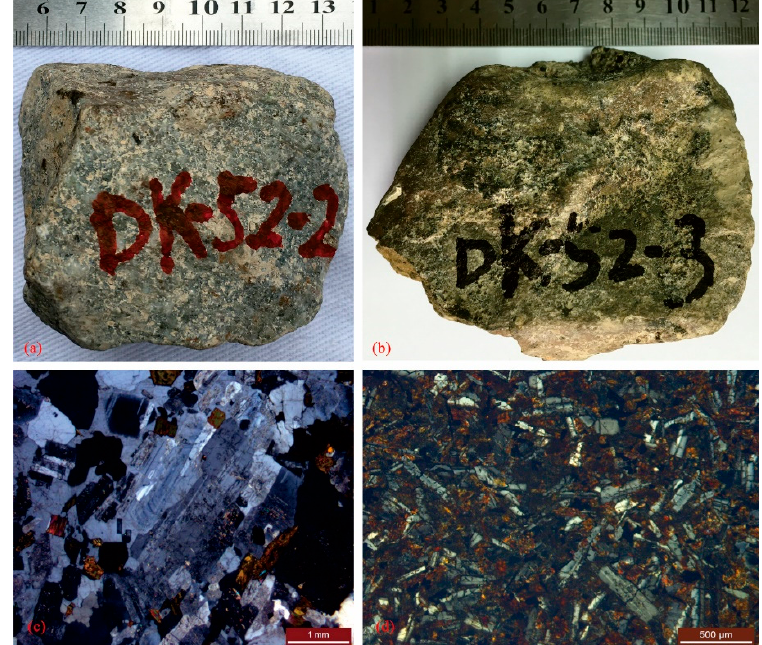
Figure 2. Photographs of granodiorite ( a ) and Nb ‐ enriched basalt (NEB) ( b ) and photomicrographs (cross ‐ polarized nicols) of granodiorite ( c ) and NEB ( d ). The NEB samples were porphyritic with large euhedral plagioclase phenocrysts (Figure 2d) and had an intergranular texture and a massive structure. Their glassy groundmass contained